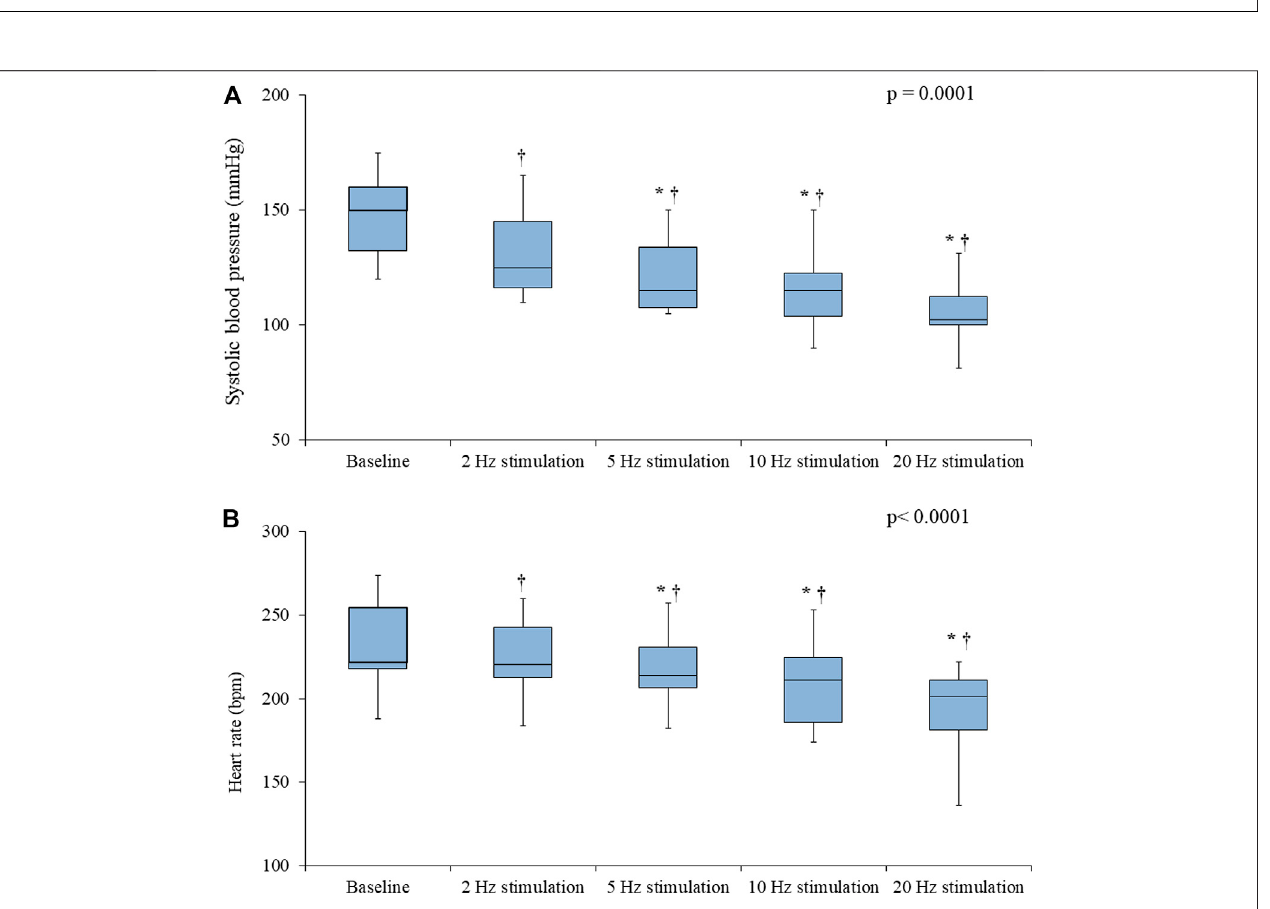
FIGURE 4 | Systolicblood pressure ( A ) and heartrate( B ) valuesprior to(baseline)and during vagusnerve stimulation at2,5,10, and 20 HzintheControlrats( n (cid:2) 6). Dataareexpressedasmedianandinterquartilerange(IQR).Theendsofthewhiskersrepresentthelowestvaluewithin1.5IQRofthe fi rstquartileandthehighestvaluewithin 1.5 IQR of the third quartile. p -values in the right upper corners were obtained using nonparametric repeated-measures ANOVA (Friedman test). * p < 0.05 vs. the value obtainedduringthepreviousstimulationusingthepairedStudent ’ s t -testortheWilcoxonmatched-pairssigned-ranktest,asappropriate; † p < 0.05vs.baselineusing the paired Student ’ s t -test or the Wilcoxon matched-pairs signed-rank test, as appropriate.